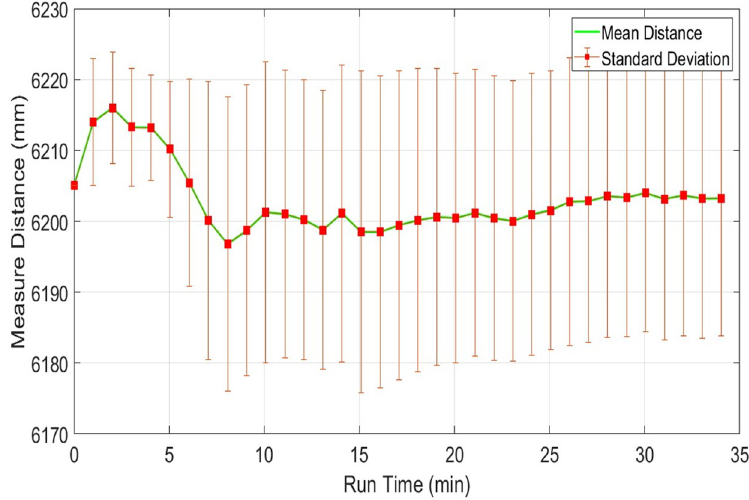
Fig 15. Range plot of RPLidar for measuring stability test for object present at 6m distance.